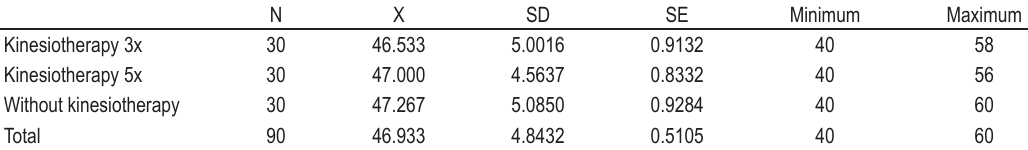
TABLE 1. Comparison of average age by the groups